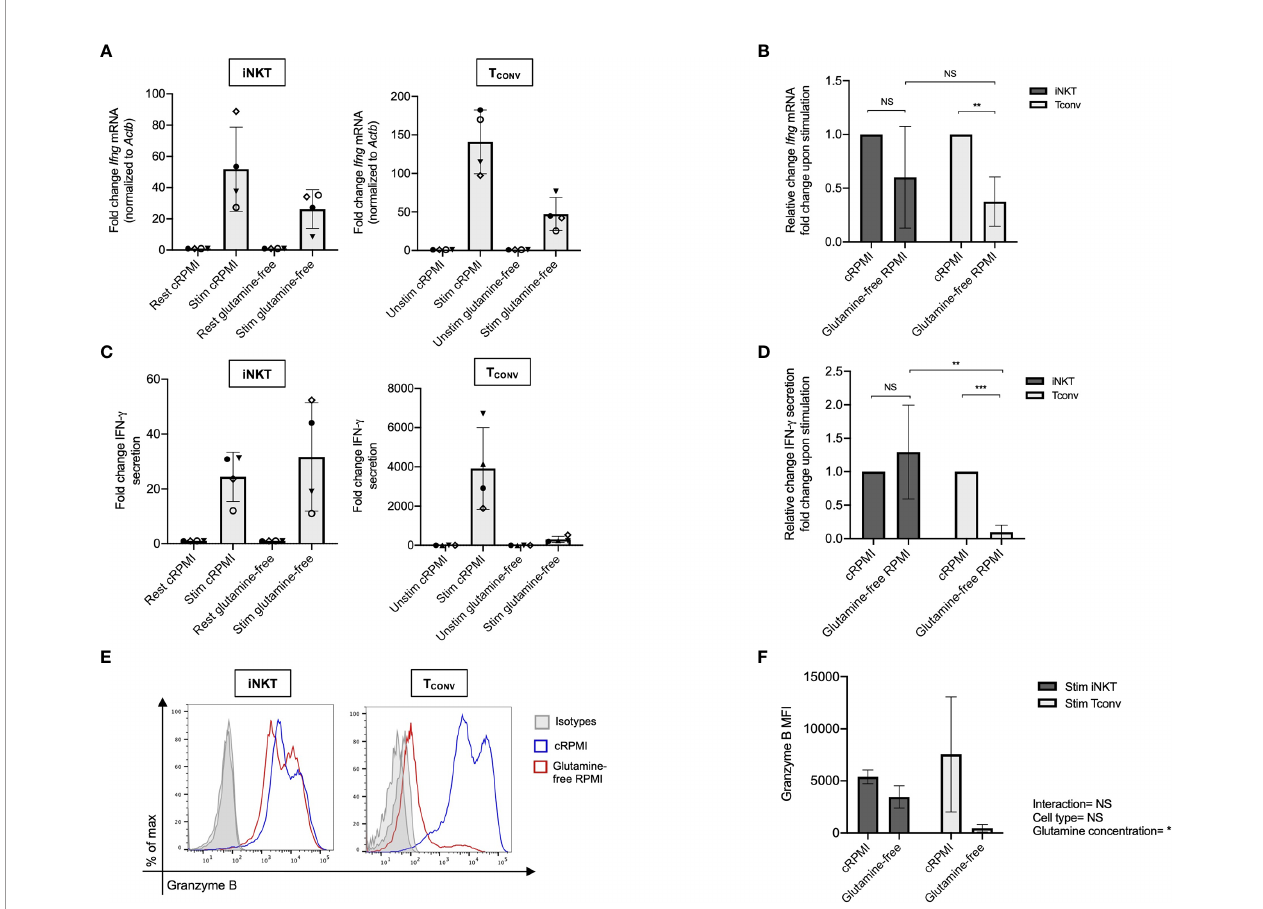
FIGURE 3 | Human iNKT cells are less reliant on glutamine for effector functions than T CONV . Sorted PBMC-derived iNKT cells and T CONV were rested or stimulated in either complete RPMI (10% FBS, 1% L-glutamine) or glutamine-free RPMI media for 48 hours per schematic in Supplementary Figure 1 . (A) mRNA expression of Ifng was determined for iNKT cells (left) and T CONV (right) at 48 hours by qPCR (with values normalized to Actb expression). Fold change induction of Ifng upon stimulation relative to rest (iNKT) and unstimulated (T CONV ) conditions displayed. Each symbol represents matched, independent human donor biological replicates. (B) Summary data offold change in Ifng Ct upon stimulation relative to cRPMI condition is depicted for iNKT and T CONV from qPCR in (A) . (C) Supernatants were collected from rested and stimulated iNKT cells (left) and T CONV (right) after 48 hours. IFN- g levels were detected via ELISA and fold change upregulation upon stimulation relative to rest (iNKT) and unstimulated (T CONV ) conditions displayed. Each symbol represents matched, independent human donor replicates. (D) Summary data of change in IFN- g secretion fold change upon stimulation relative to cRPMI is depicted for iNKT and T CONV from ELISA in (C) . (E) Rested and stimulated iNKT cells and T CONV from matched human donors were stained for intracellular Granzyme B or isotype control; histogram of live, stimulated iNKT cells and T CONV representative of 4 matched, independent human donor samples. (F) Quanti fi cation of granzyme B mean fl uorescence intensity (MFI) of stimulated iNKT cells and T CONV normalized to isotype MFI indicated in bar graph. In all graphs, asterisks denote statistical signi fi cance (NS, non-signi fi cant; *p < 0.05, **p < 0.01, ***p < 0.001) determined by unpaired, two-way student ’ s t tests in (B, D) and two-way analysis of variance (ANOVA) analysis in (F) . For all studies, biological replicates of human donor samples are indicated by symbols, and n=4 technical replicates were performed. Each biological replicate of matched donor cells was run in independent